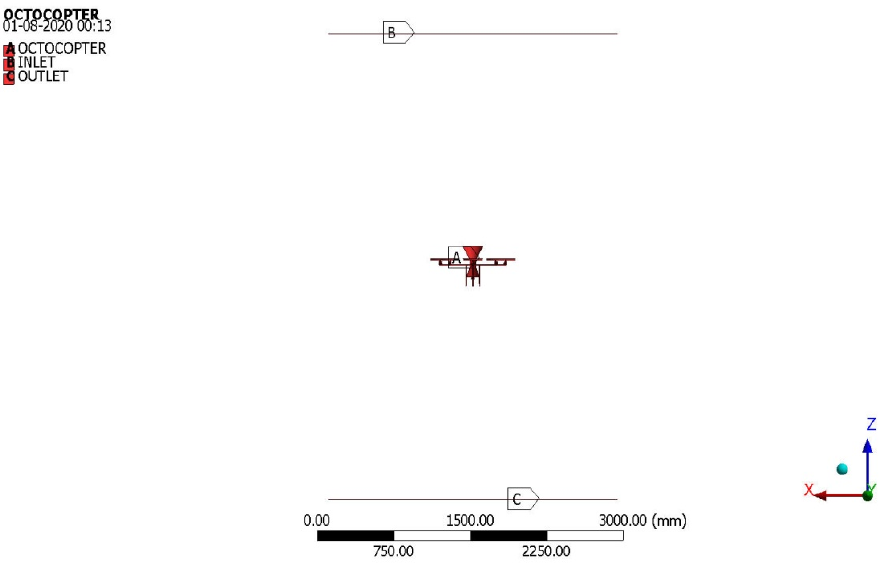
Figure 16. External control volume with